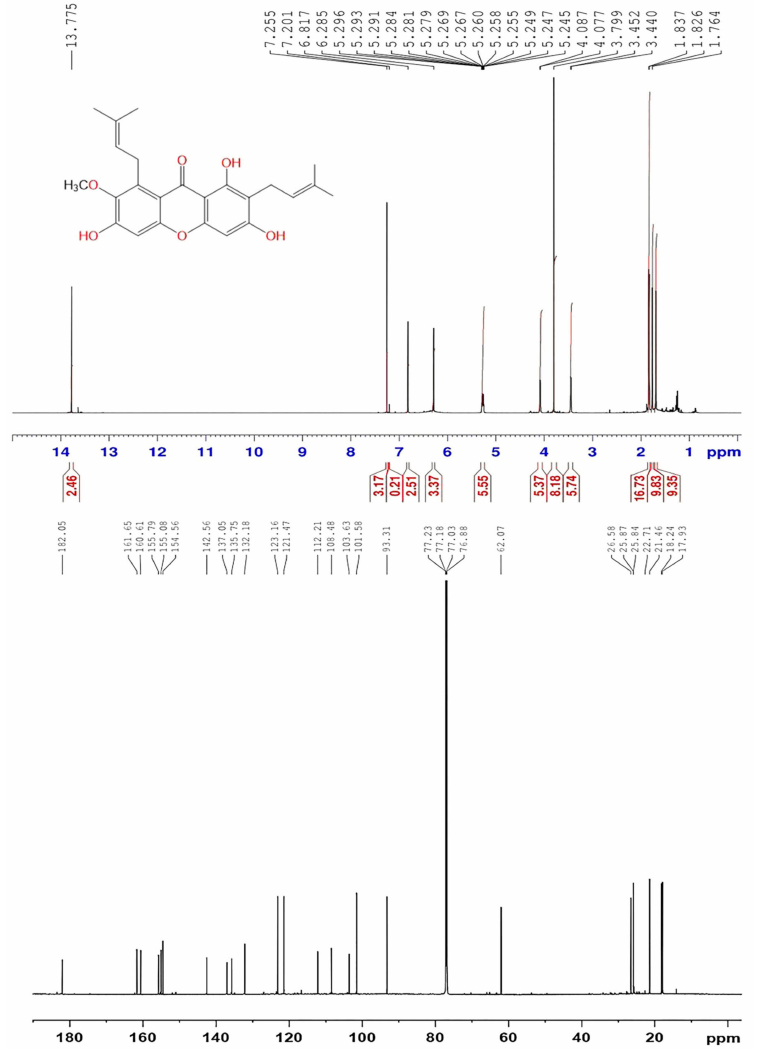
Figure 2. 1 H (600 MHz) and 13 C (150 MHz) NMR spectra of α -MN in CDCl 3